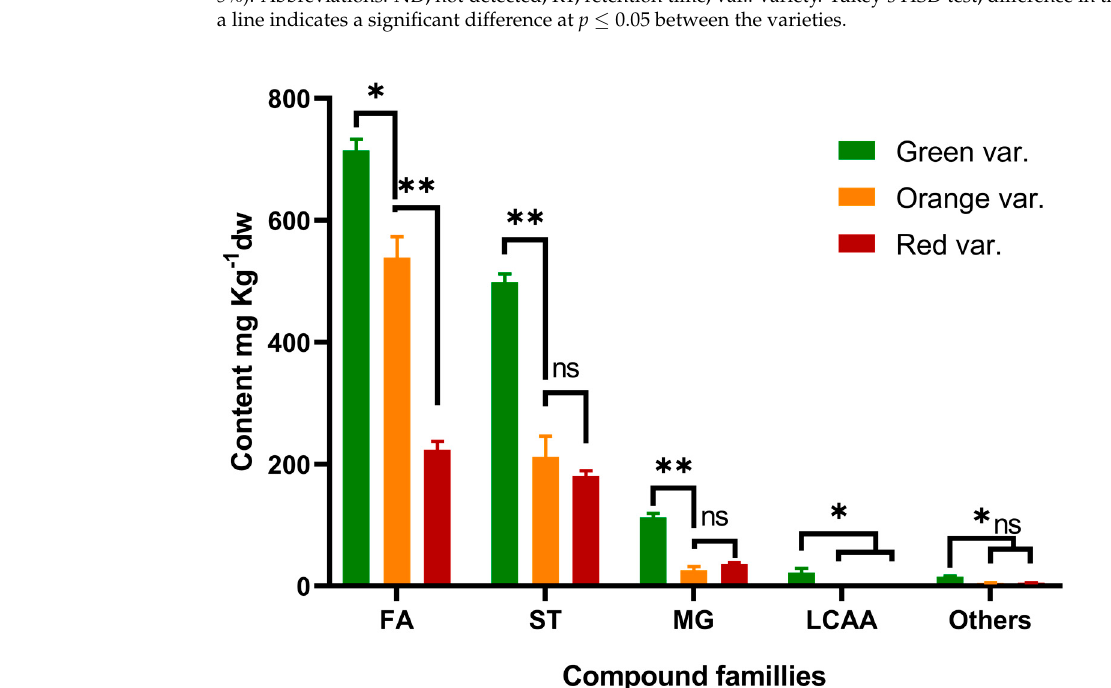
Figure 2. Major families of lipophilic compounds identified in dichloromethane extracts of three varieties of Opuntia ficus-indica roots. *, significant difference at p ≤ 0.05; **, significant difference at p ≤ 0.01; ns, non-significant difference.